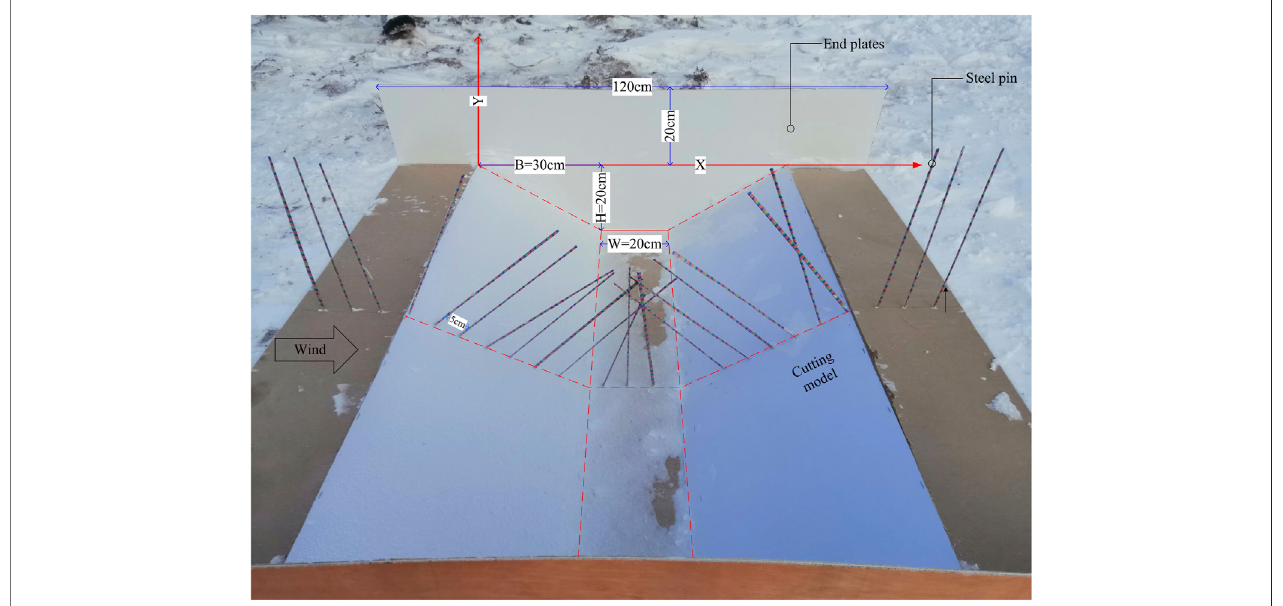
FIGURE4 | Field measurement model. Figure 4 is aphoto ofthe cutting model in this fi eldmeasurement. The coordinate axes and model dimensionsare marked in the fi gure. Furthermore, the fi gure also shows the measurement method of snow depth, which is some steel drills with red, yellow, and blue labels placed on the